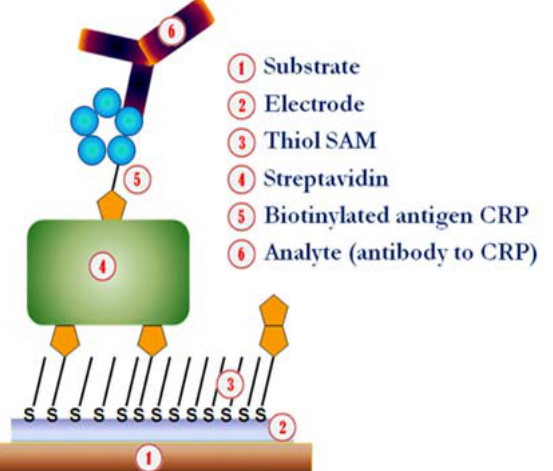
Figure 1. Schematic diagram of the structure (not to scale) of the supramolecular protein layers streptavidin, biotinylated c-reactive protein (CRP) antigen and the bound analyte (anti-CRP antibody) grown on biotinylated self-assembly monolayer (SAM)-covered printed gold electrodes on a paper